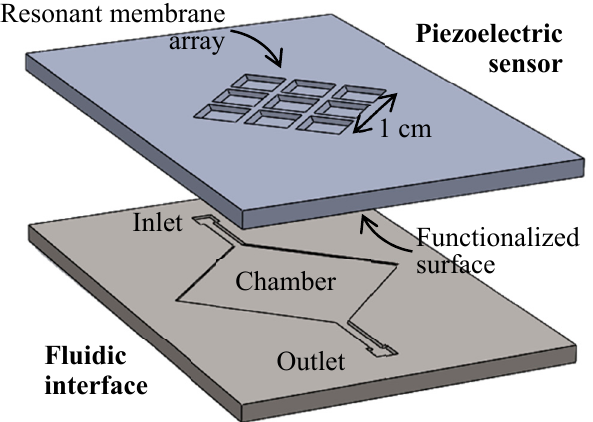
Figure 1. Exploded view of an acoustic biomedical microelectromechanical systems (BioMEMS) sensor, based on the assembly of an array of functionalized piezoelectric membranes with a microfluidic interface, for real time monitoring of specific molecules capture.